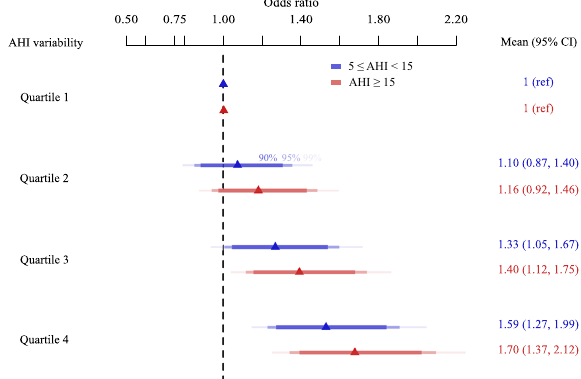
Fig. 4 Association between nightly variation in obstructive sleep apnea severity with uncontrolled hypertension. Odds ratio (mean and 95% con fi dence interval) of the association between obstructive sleep apnea severity as measured by the mean apnea – hypopnea index (AHI), and night – night variability in AHI, measured by the SD of AHI, with uncontrolled hypertension. Mild OSA is de fi ned as an AHI between 5 and 15 events/h. Moderate/severe OSA is de fi ned as an AHI > 15 events/h. Within each OSA severity category, the lowest quartiles of variability in AHI are taken as the